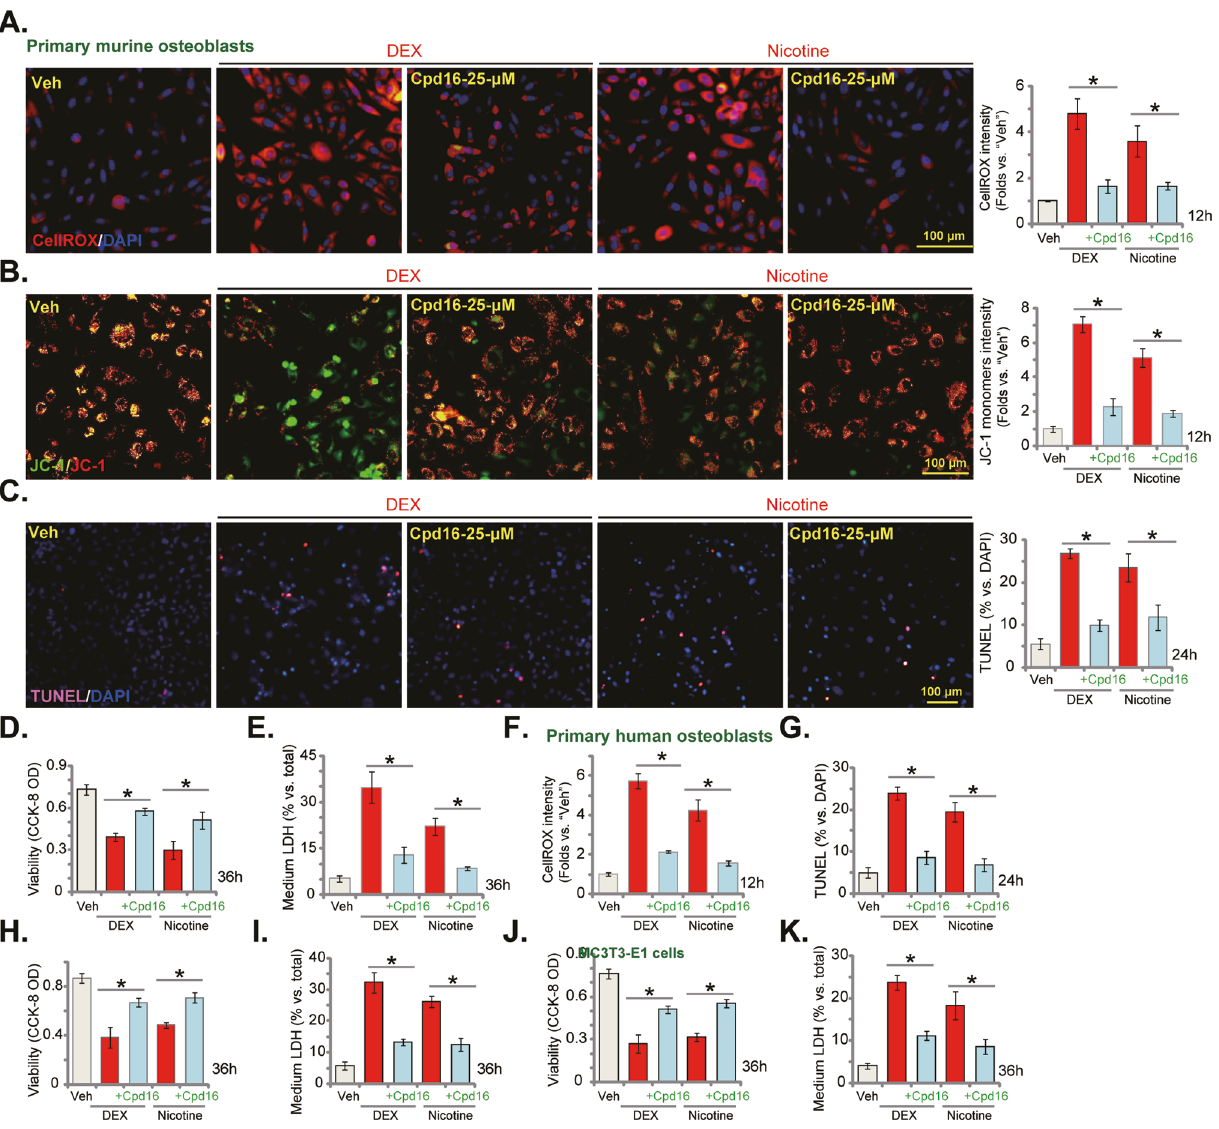
Fig. 5 Cpd16 inhibits dexamethasone- and nicotine-induced oxidative injury in osteoblasts. The primary murine osteoblasts ( A – E ), human osteoblasts ( F – I ), or the MC3T3-E1 murine osteoblastic cells ( J , K ) were pretreated (for 2 h) with Cpd16 (25 μ M), followed with or without dexamethasone (DEX, 2 μ M) or nicotine (1 μ M) treatments, ROS, depolarization of mitochondria, apoptosis, viability, and necrosis were tested by CellROX staining ( A , F ), JC-1 staining ( B ), TUNEL-nuclei staining ( C , G ), CCK-8 ( D , H , J ), and LDH releasing ( E , I , K ) assays, respectively. * P < 0.05. Scale bar = 100 μ m ( A – C